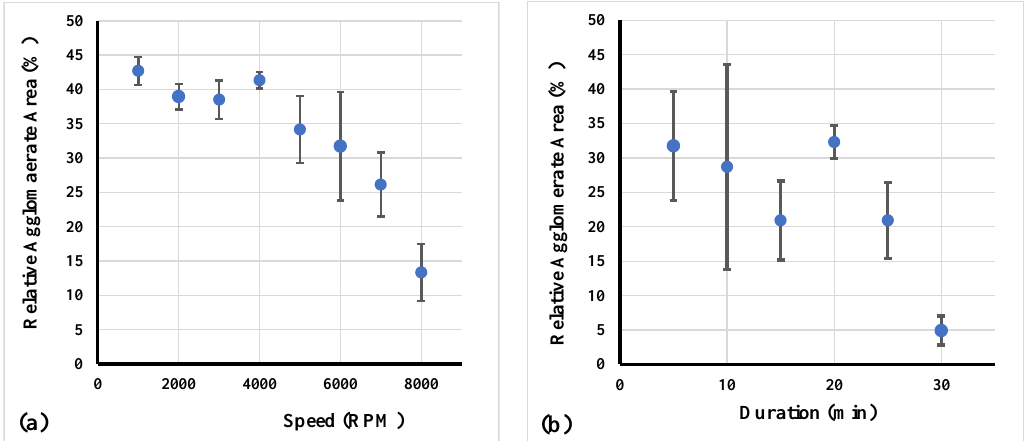
Figure 8. Relation of the relative agglomerate area by changing ( a ) revolution speed and ( b ) treatment duration of RS.